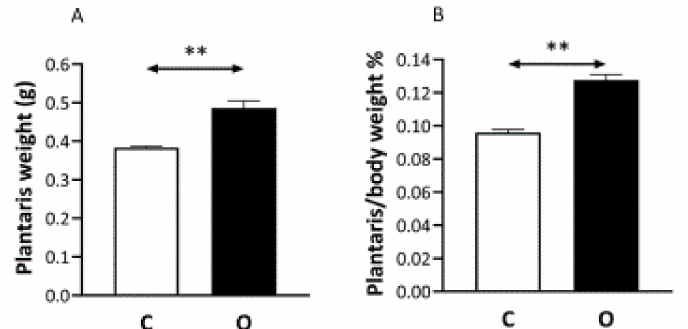
Figure 1. The effects of overload on muscle mass. The removal of gastrocnemius and soles muscles resulted in greater weight carrying load on the plantaris muscle, which significantly increased in the muscle mass of plantaris (O) compared to control (C) muscle (Panel ( A )). Panel ( B ) shows the muscle in a relation to body mass is expressed. n = 9, ** p < 0.01, Results are expressed as mean ±